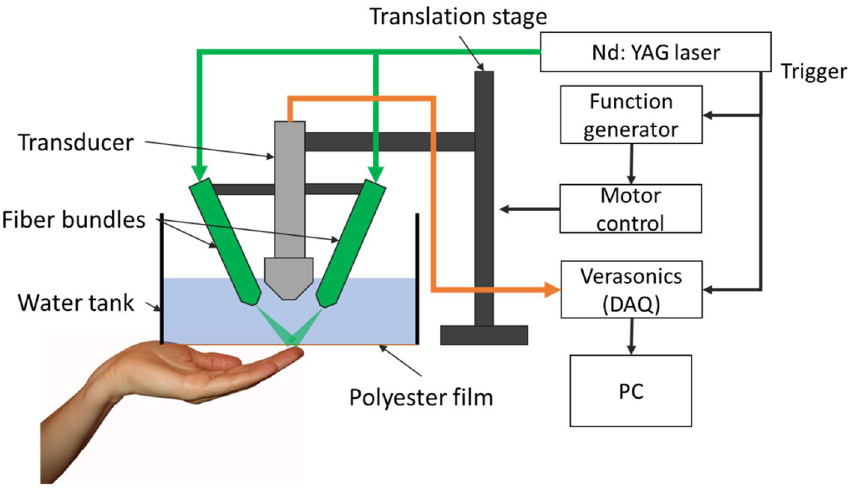
Figure 1. Schematic diagram of the PAT fingerprint imaging